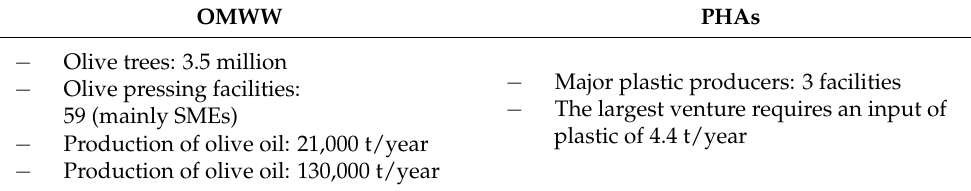
Table 2. Prefecture of Achaia: Data on OMWW supply and PHAs demand.